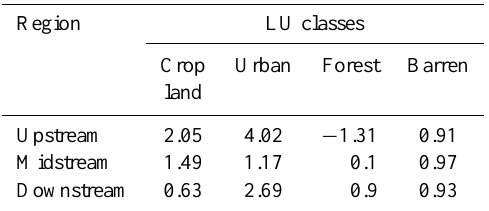
Table 4. Runoff/LU ratio for different LU categories for upstream, midstream and downstream